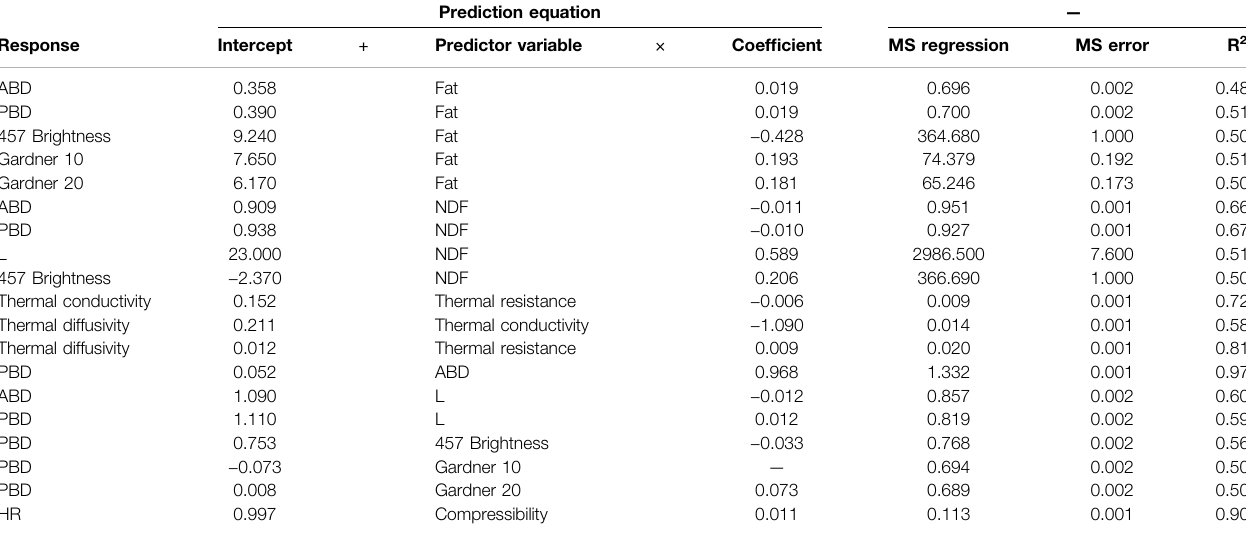
TABLE 4 | Linear regression results for those variable combinations which exhibited signi fi cant linear correlations.